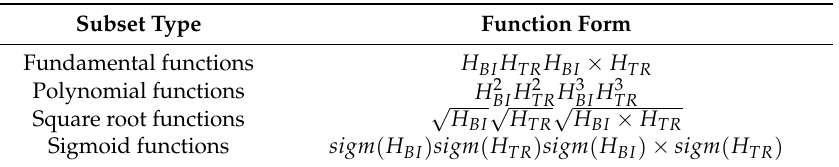
Table 1. Candidate basis functions for FOS